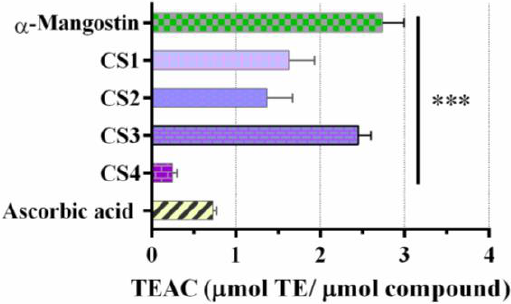
Figure 4. Antiradical activity of α -mangostin and synthetic compounds CS1-CS4 tested with ORAC assay. Positive control: ascorbic acid. Data are the mean ± SEM of 3 – 6 experiments. *** p < 0.001 vs. positive control. The ORAC values are expressed as TEAC (trolox equivalent antioxidant capacity).